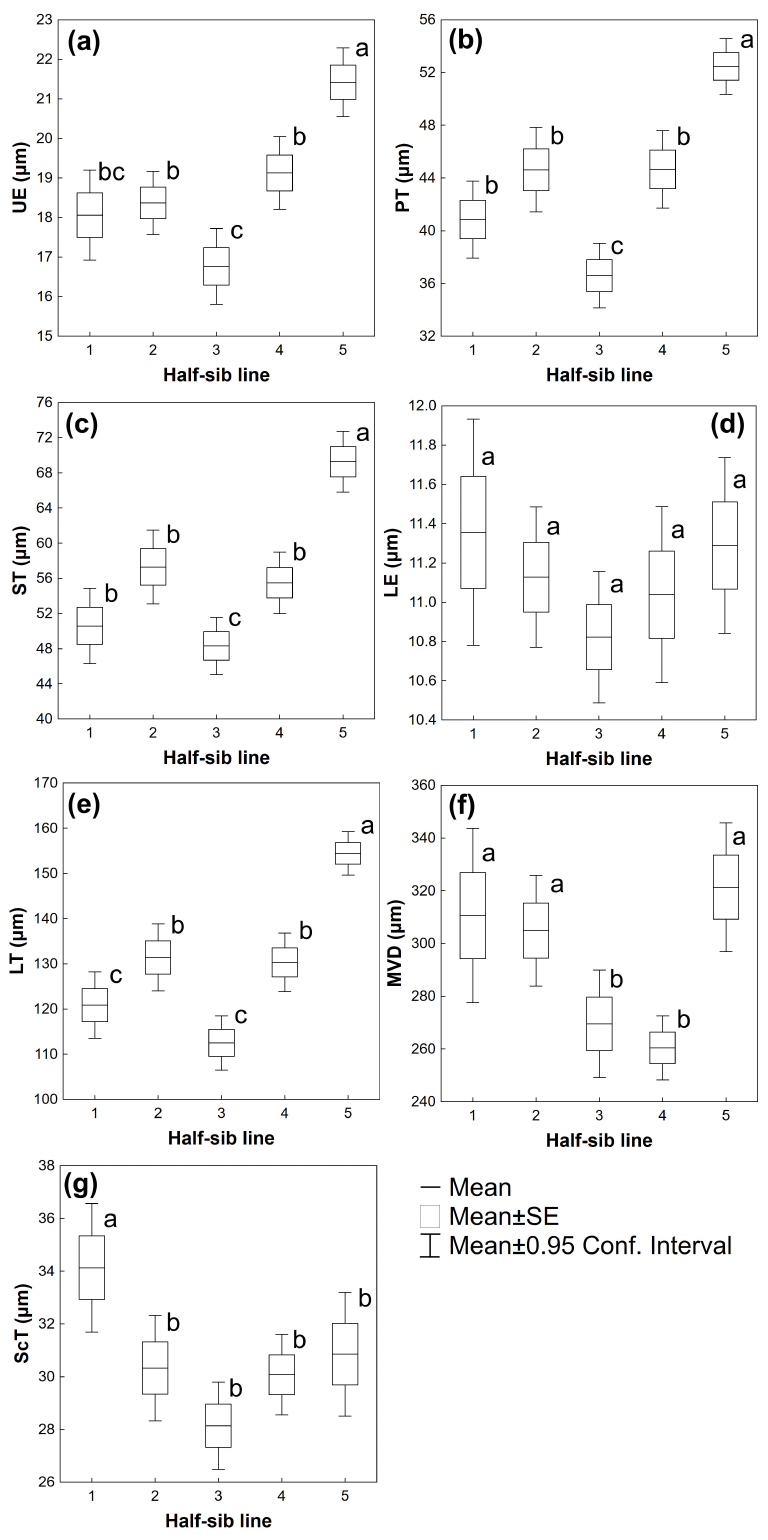
Figure 4. Leaf anatomical traits: of Q. robur L. half-sib lines. ( a ) Adaxial epidermis thickness (UE, µ m), ( b ) palisade parenchyma thickness (PT, µ m), ( c ) spongy parenchyma thickness (ST, µ m), ( d ) abaxial epidermis thickness (LE, µ m), ( e ) lamina thickness (LT, µ m), ( f ) main vein diameter (MVD, µ m), ( g ) sclerenchyma thickness (ScT, µ m). Values are means ± standard errors ( n = 9; di ff erences of UE, PT, ST, LT, MVD parameters among half-sib lines are reported (Dunkan’s multiple range test; p ≤